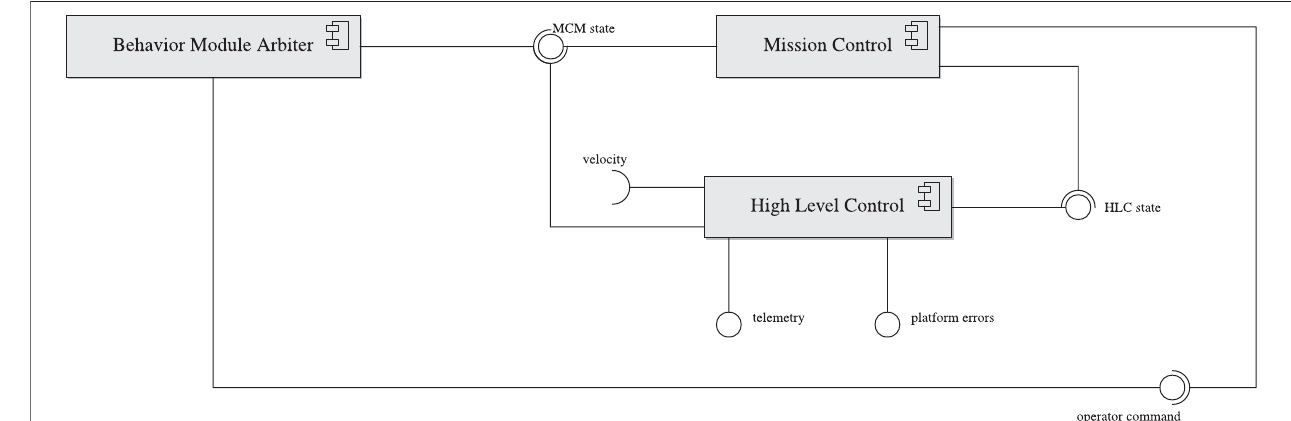
FIGURE 4 | AntAlate minimal deployment.